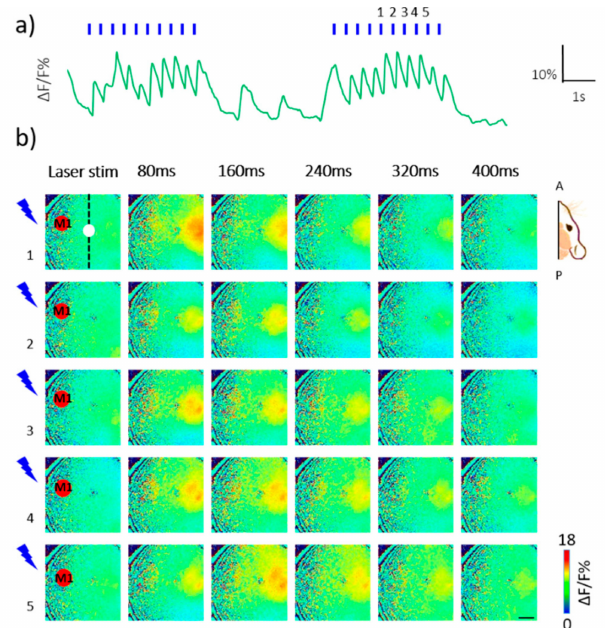
Figure 2. Optogenetic inter-hemispheric stimulation. ( a ) Representative trace of optogenetically elicited cortical response in the right hemisphere during two train of stimulation from a single animal (2 Hz, 5 ms pulse duration); the blue lines represent laser stimulus. ( b ) Representative image sequence from the same recording in A, showing cortical activation in the right hemisphere elicited by 2 Hz pulse of a 473 nm blue laser stimulation in ChR2-expressing M1 in the left hemisphere. Each row corresponds to cortical activity triggered by a single pulse during 2 Hz stimulation. The vertical dashed line indicates the sagittal suture. The white spot on the vertical dashed line indicates the bregma. The red spot in the left hemisphere indicates the transfected M1. A, P: Anterior, Posterior. Scale bar: 1